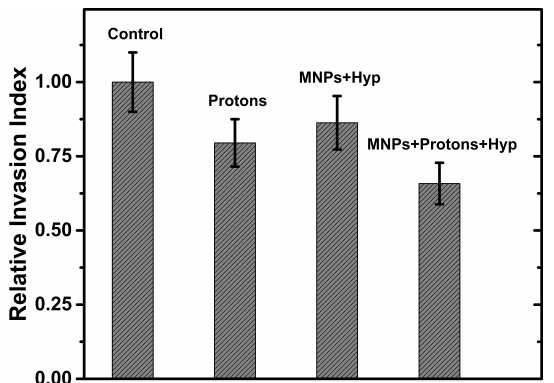
Figure 8. The relative invasion index of BxPC3 cells exposed to protons, and treated or not with MNPs and hyperthermia. Control: untreated cells; Protons: cells irradiated with 4 Gy of protons; MNPs+Hyp: cells with MNP-50 µ g/mL and hyperthermia treatment; MNPs+Protons+Hyp: cells with MNP-50 µ g/mL, irradiated with 4 Gy of protons and hyperthermia treatment. Error bars represent one standard error of the mean of two